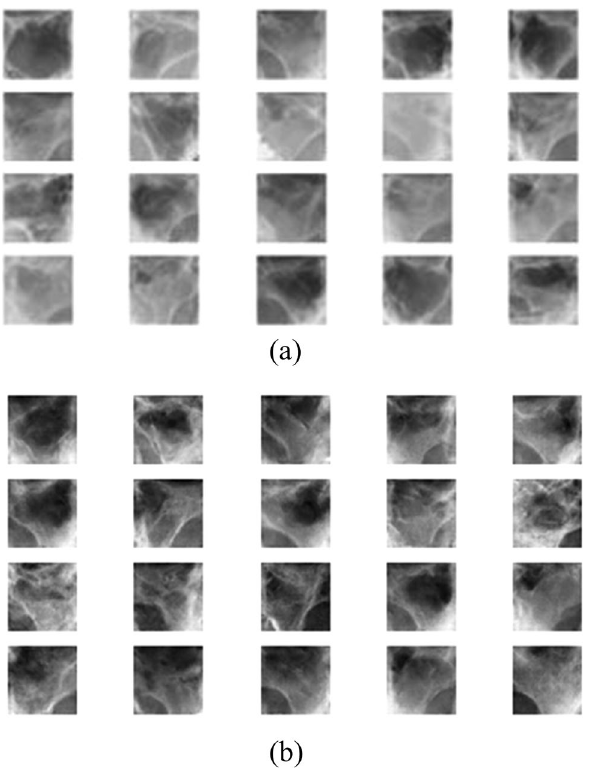
Figure 6. Clear sinus and sinusitis of maxillary sinuses. ( a ) Original images. ( b ) Synthetic images.